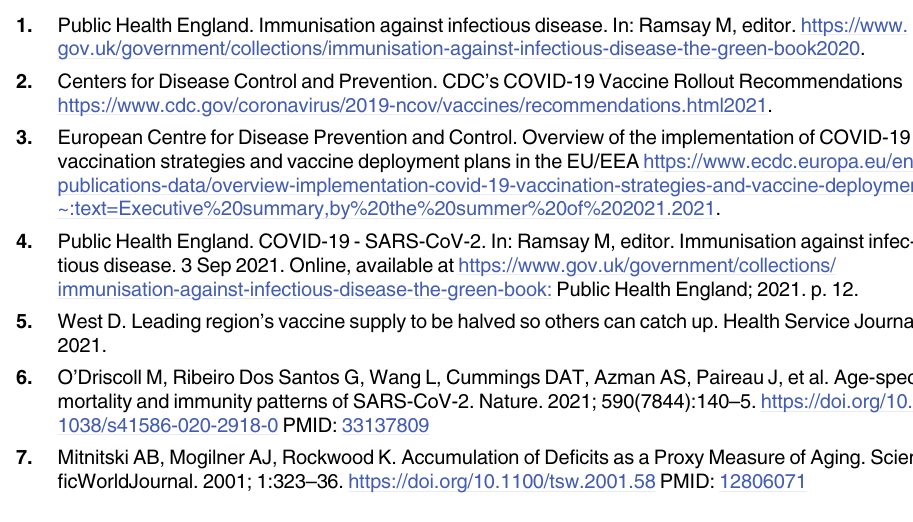
S3 File. Number of first vaccine doses administered, relative to the number of people diag- nosed with a range of risk factors, in each Clinical Commissioning Group area. S1 Fig. Heatmap of first vaccine doses administered relative to the number of people diag- nosed with risk factors associated with COVID-19, for all Clinical Commissioning Group (CCG) areas of England. The risk factors are associated with infection, hospitalisation and mortality due to COVID-19. The ratio of first vaccine dose to the number of people with each risk factor (by quintile), in each area, are shown. Area deprivation quintiles (measured by the English Index of Multiple Deprivation) are also shown. All Clinical Commissioning Group areas in England are